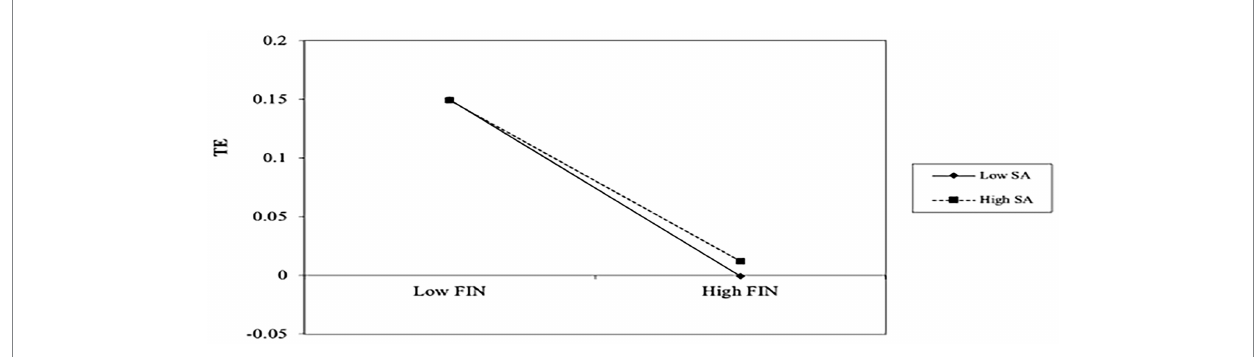
FIGURE 3 Moderating effect of financing